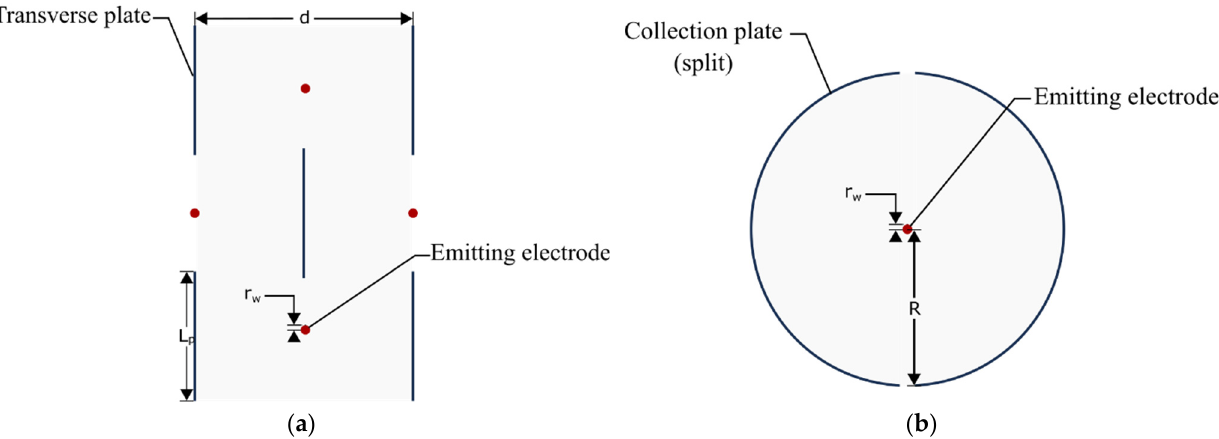
Figure 2. Schematic of two distinct collecting electrode configurations: ( a ) transverse plate type ESP; ( b ) wire-cylinder type ESP.